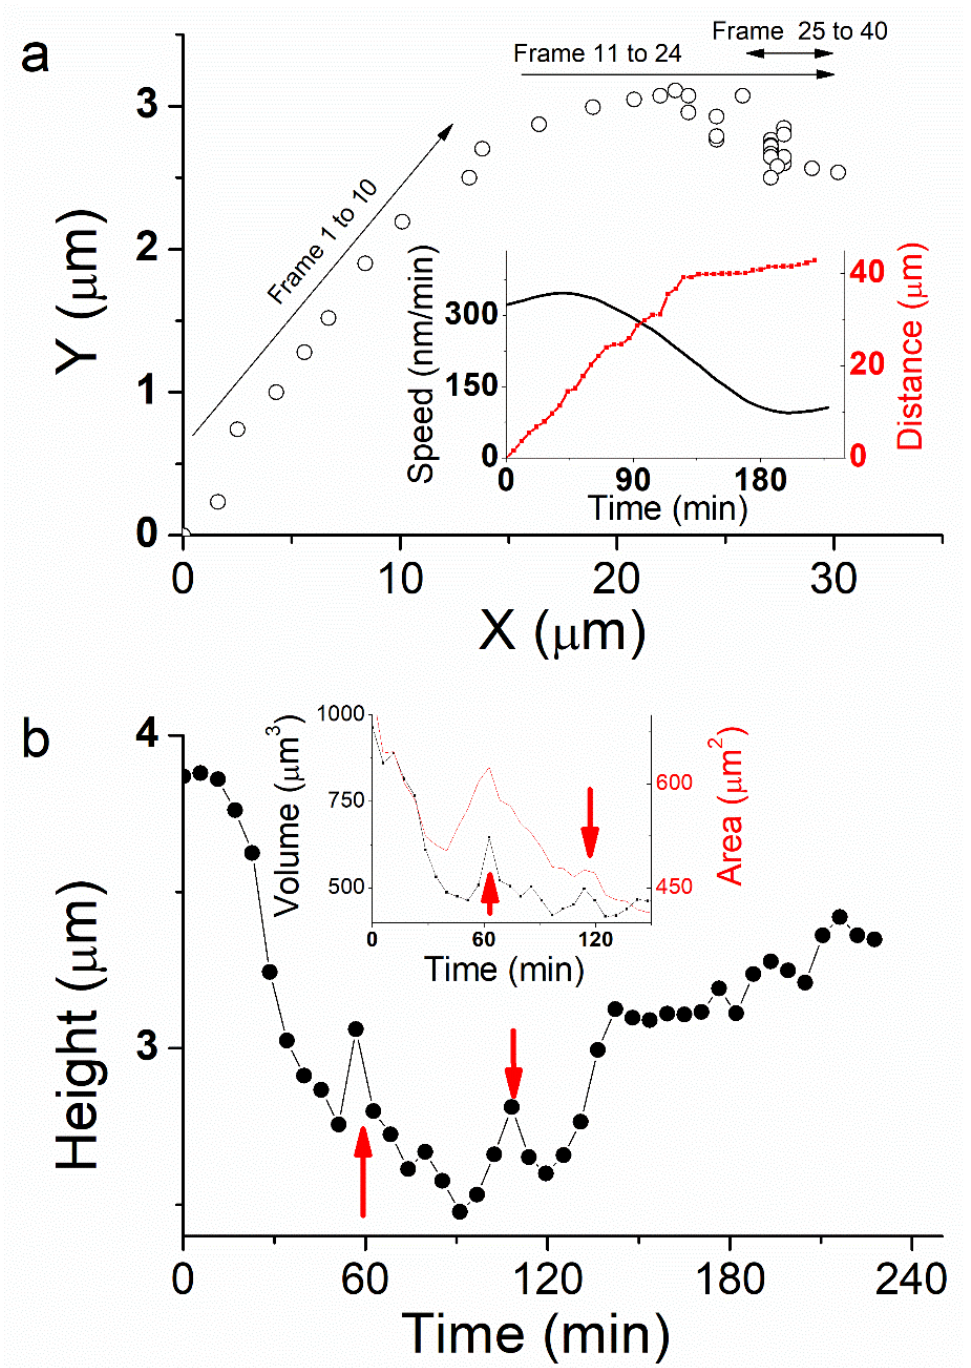
Figure 2. ( a ) Trajectory of the cell plotted as the position of the cell for the aligned images. Each point (open circle) corresponds to the position of the cell in a single frame. Cell speed and total traveled distance are calculated from the plot (Inset black and red curves respectively). ( b ) Cell maximum height, as well as volume and area (Inset black and red curve respectively) is calculated from each image during cell motion.